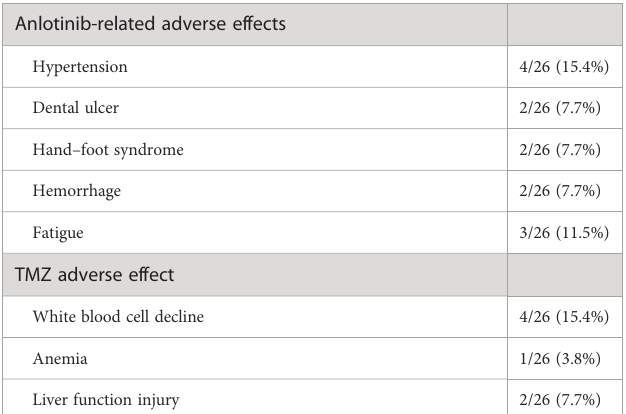
TABLE 2 Adverse